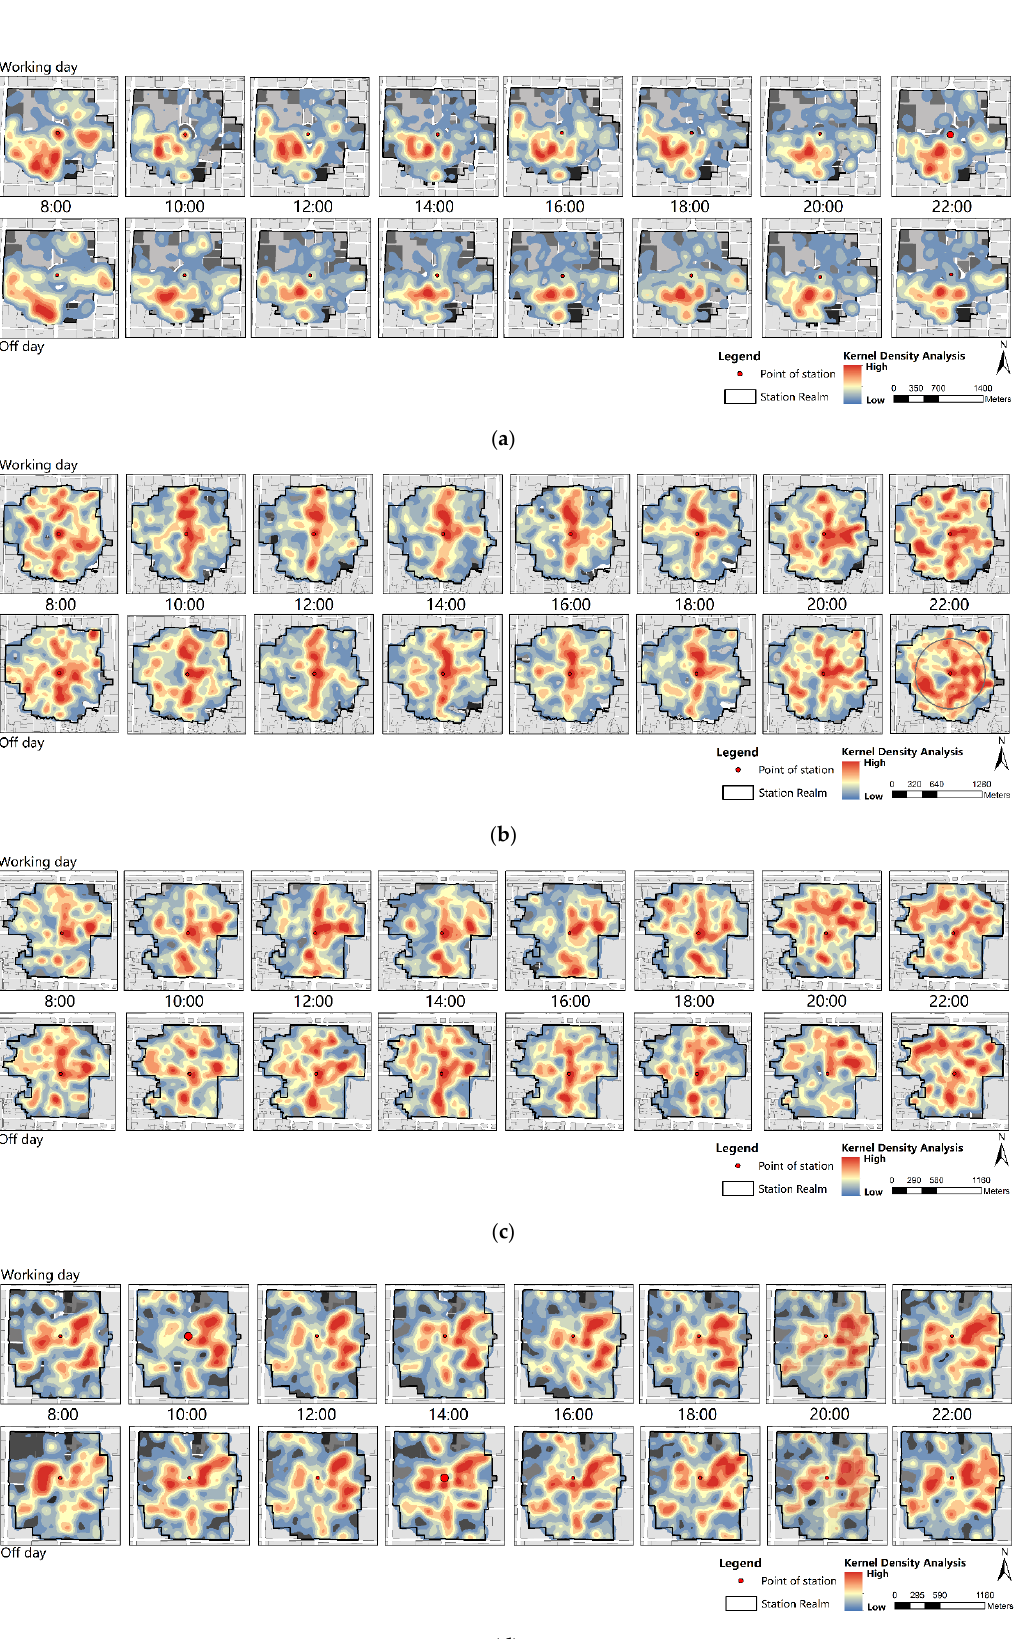
Figure 10. Temporal and spatial distribution of human activities in each study station realm: ( a ) XZZX Station, ( b ) LSY Station, ( c ) BDJ Station, ( d ) WYJ Station.